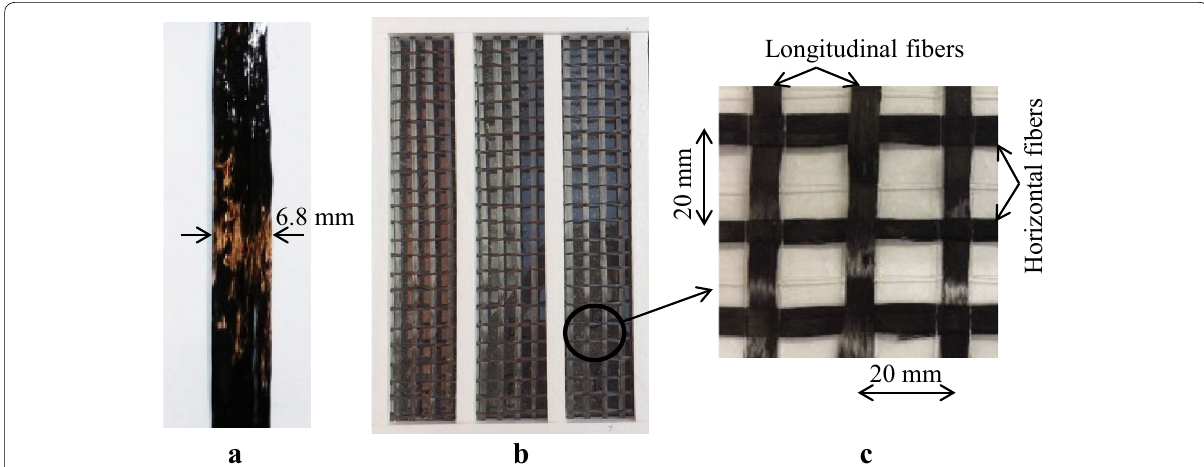
Fig. 1 Details of carbon fiber mesh used as textile reinforcement. a Carbon fiber filament provided by manufacturer, b Carbon fiber mesh, c Geometrical dimensions.